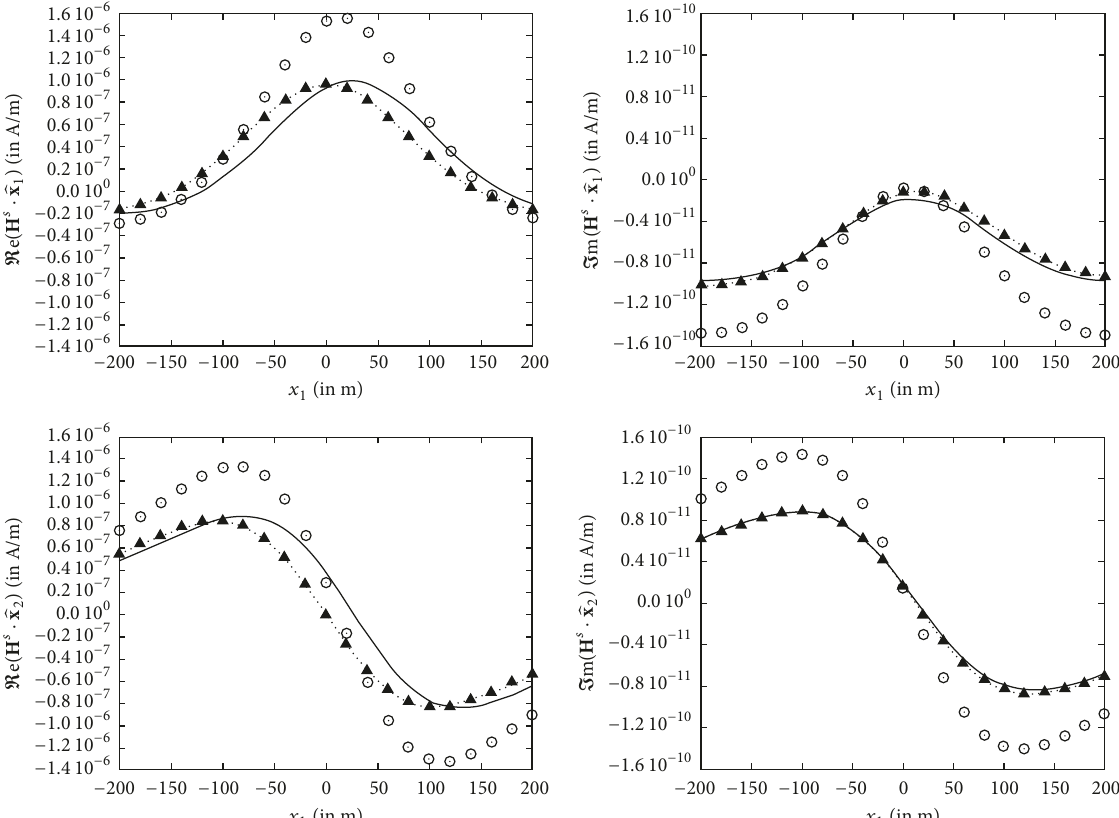
Figure 2: The 𝑥 1 -components and 𝑥 2 -components of the real and the imaginary parts of the approximated low-frequency scattered magnetic field H 𝑠 , obtained on the 𝑥 1 -axis for a prolate spheroid ( ⋅⋅⋅󳵳⋅⋅⋅ ), a needle ( ⊙ ), and a sphere (—). The 𝑥 3 -components are all